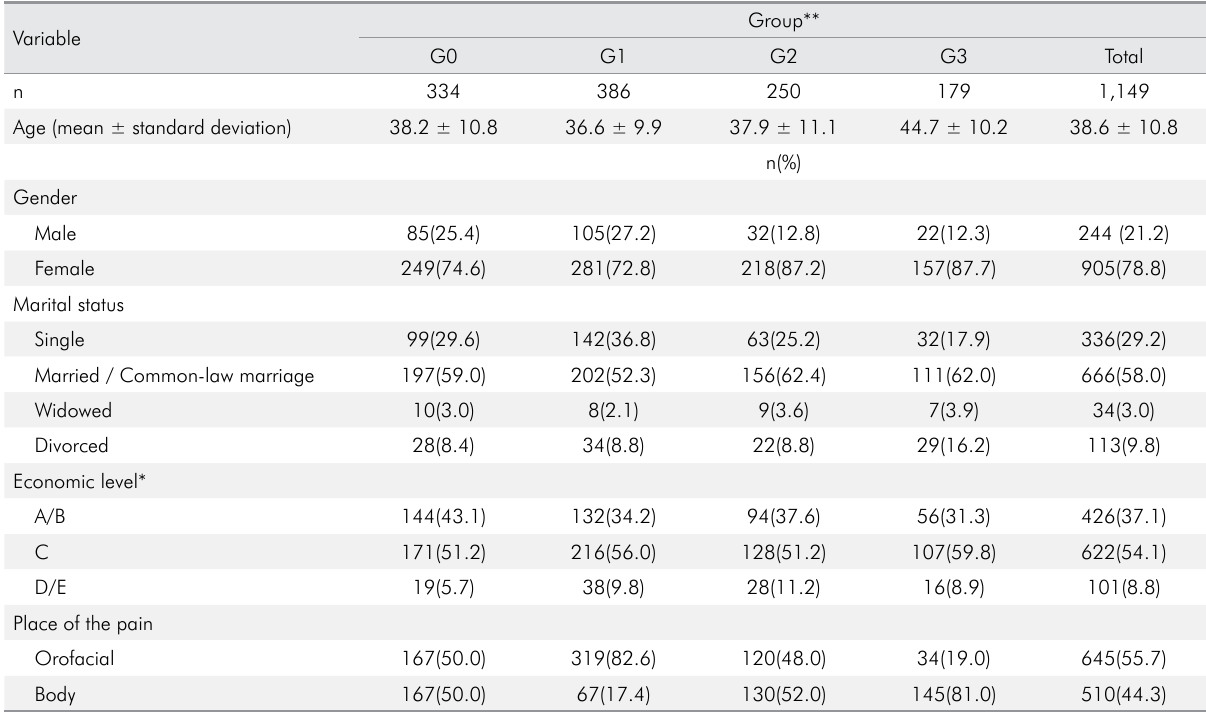
Table 3. Sample characteristics.